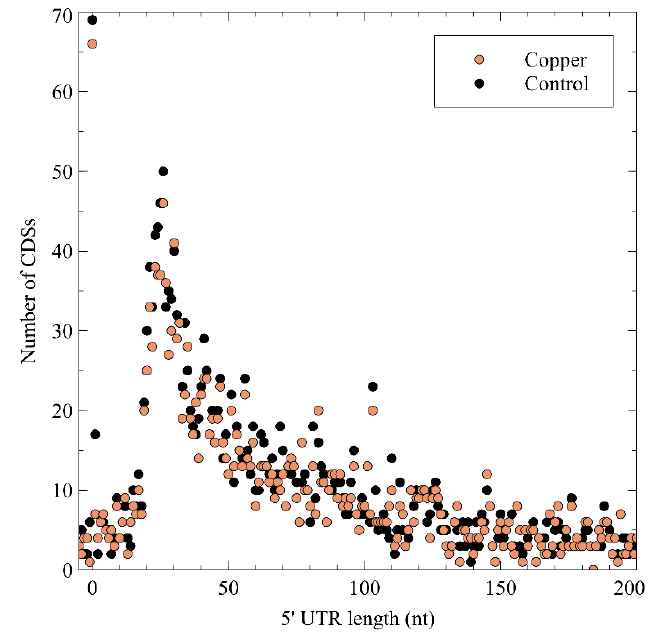
Figure 3. The 5 ′ untranslated region (UTR) length distribution in the C. metallidurans transcriptomes. CDS: coding sequence.